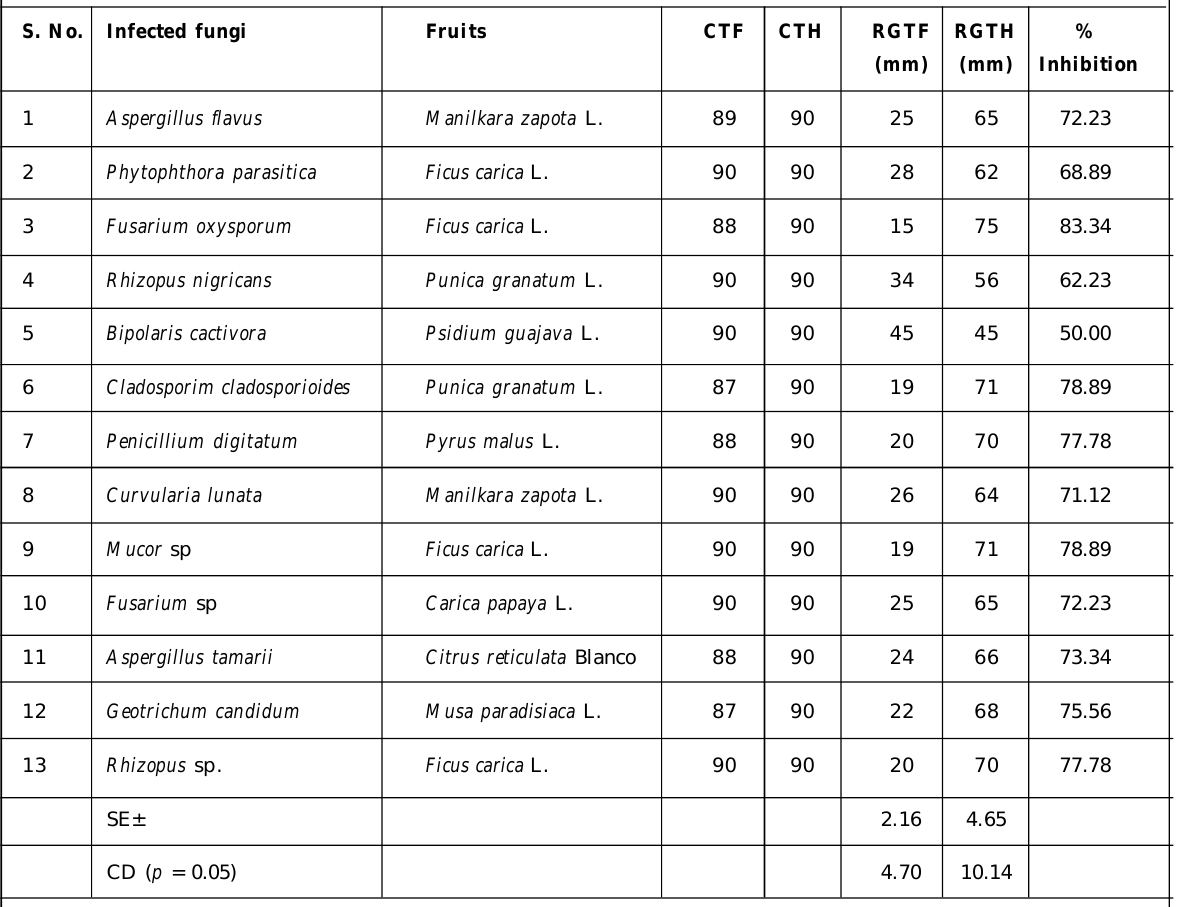
Table 1: Antagonistic activity of Trichoderma harzianum against fruit rots pathogens S. No. Infected